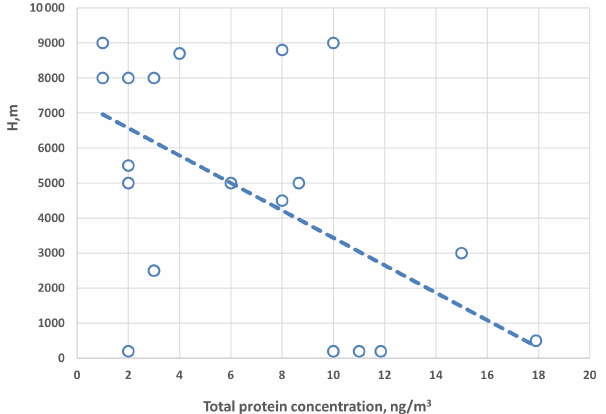
Figure 17. Total protein concentration in atmospheric aerosol sam- pled over the Russian Arctic seas.